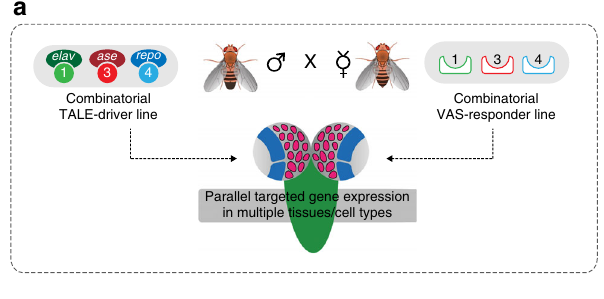
Fig. 5 High-speci fi city multiplex transgene expression in Drosophila nervous system. a Diagrammatic representation of the experimental framework used for TALE – VAS-mediated parallel transgene expression in multiple tissues in vivo. Tissue-speci fi c expression of three independent transgenes is achieved in the F0 generation by crossing combinatorial driver and responder lines. b Simultaneous expression of mCherry in neuroblasts (red), Citrine in neurons (green), and Cerulean in surface glia cells (white) by three independent TALE – VAS pairs in a single Drosophila larval CNS ( elav 1.8kb -TALE 1 , ase 0.8kb -TALE 3 , repo 1.9kb -TALE 4 > VAS 1 -Citrine-HA , VAS 3 - V5-mCherry , VAS -FLAG-Cerulean ; dorsal view of un fi xed CNS). c High- 4 magni fi cation imaging of the right optic lobe from the same genotype in b illustrating the three distinct populations of labelled neighbouring cells (neuroblasts, neurons, and glial cells). d High-magni fi cation imaging of a larval segmental nerve showing an axonal bundle (Citrine, green) ensheathed by a glial cell (Cerulean, white). The ase 0.8kb -TALE 3 driver is inactive in this tissue. e The NMJ innervating muscle 6 and 7 from elav 1.8kb - TALE mhc 2.4kb -TALE repo 1.9kb - TALE > VAS -Citrine-HA , VAS -V5-mCherry , 1 , 3 , 4 1 3 VAS -FLAG-Cerulean larvae. The post-synaptic muscle fi eld is labelled by 4 mCherry expression (red) and the neuronal pre-synaptic terminal by Citrine (green). The repo 1.9kb - TALE 4 driver is inactive in this tissue. Scale bars = 100 µ m ( b ), 25 µ m ( c , e ), 10 µ m ( d